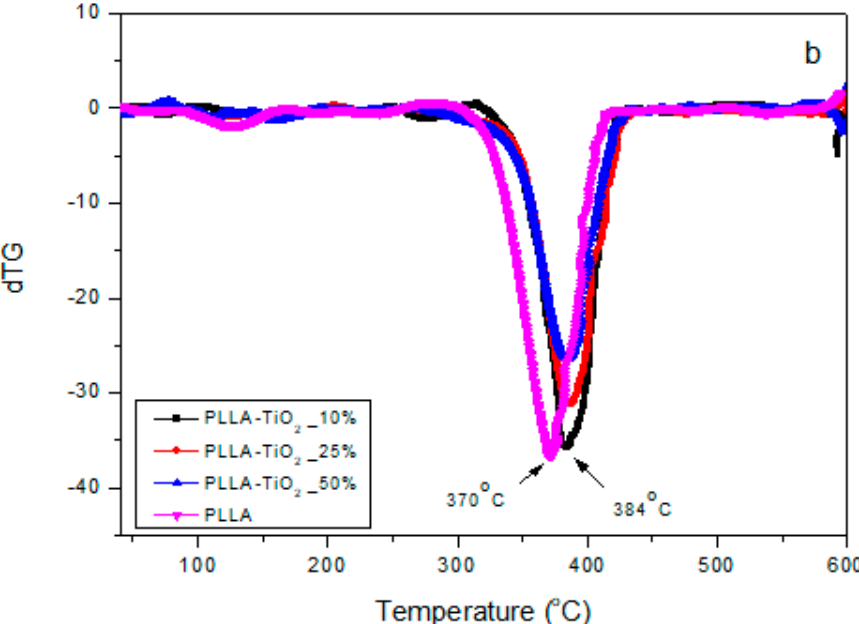
Figure 1. ( a ) Mass loss and ( b ) DTG curves of prepared PLLA GO–TiO 2